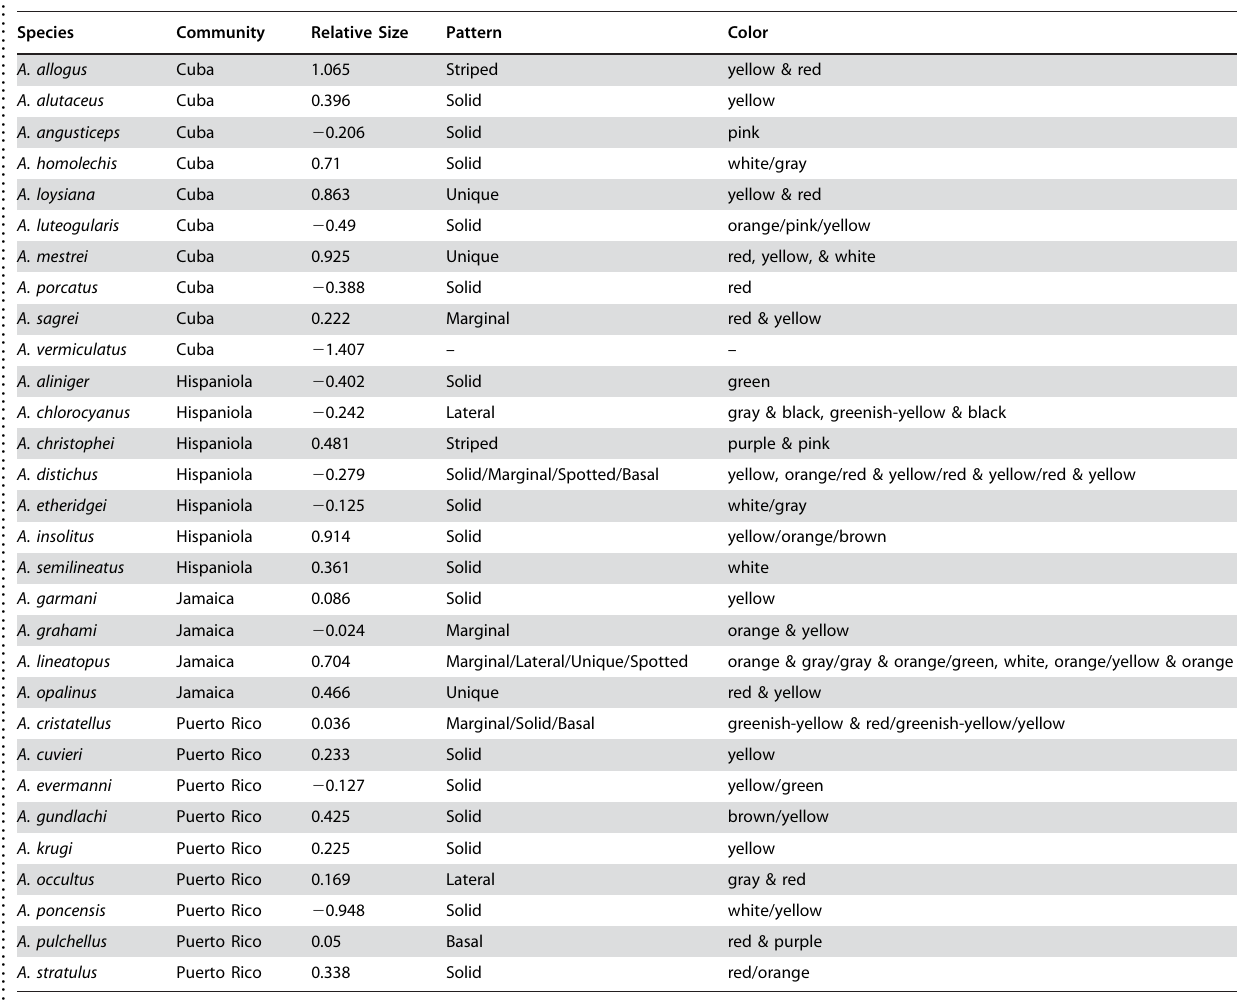
Table 5. Data used to test the Species Recognition hypothesis. .. ... .... ... ... .... ... ... .... ... ... .... ... ... .... ... ... .... ... ... .... ... ... .... ... ... .... ... ... .... ... ... .... ... ... .... ... ... .... ... ... .... ... ... .